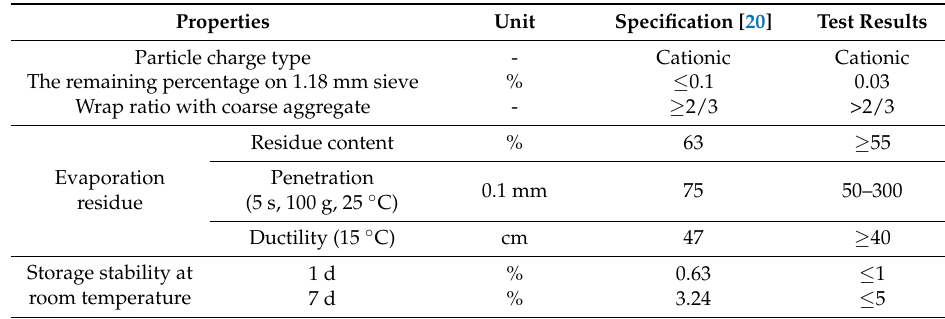
Table 3. Properties of emulsified asphalt.